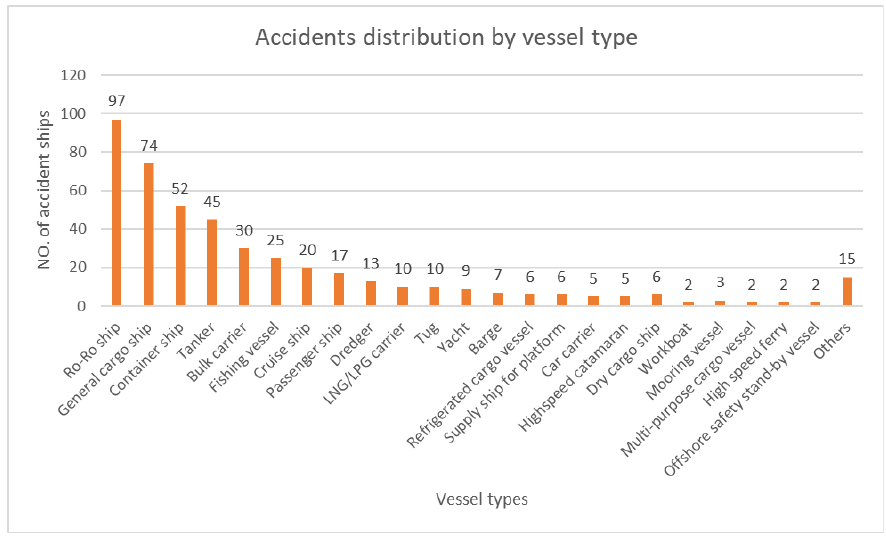
Figure 6. Accident distribution by vessel type.